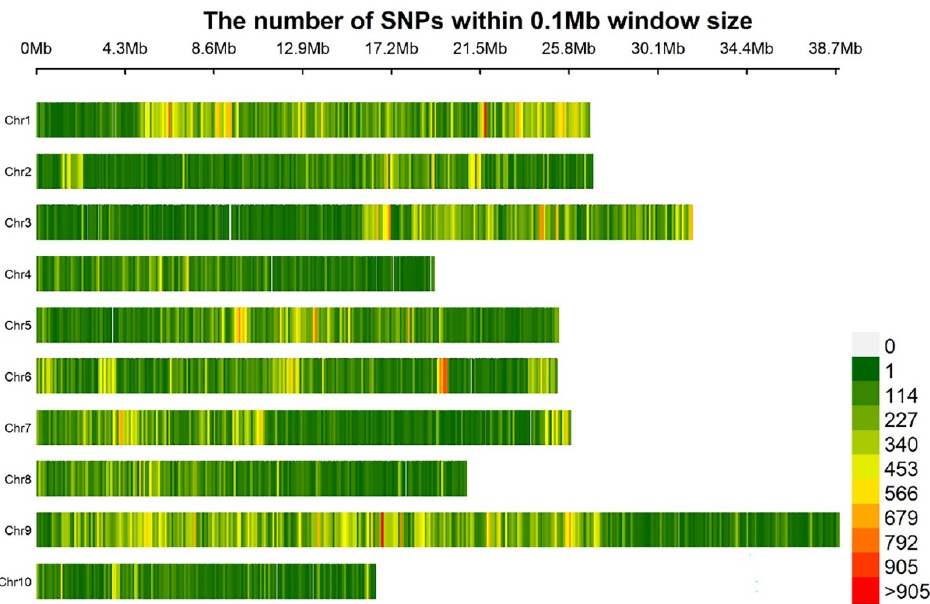
Figure 2. Distribution of F 2:3 families’ disease levels (disease index) after testing with Pbh of P. bras- sicae .